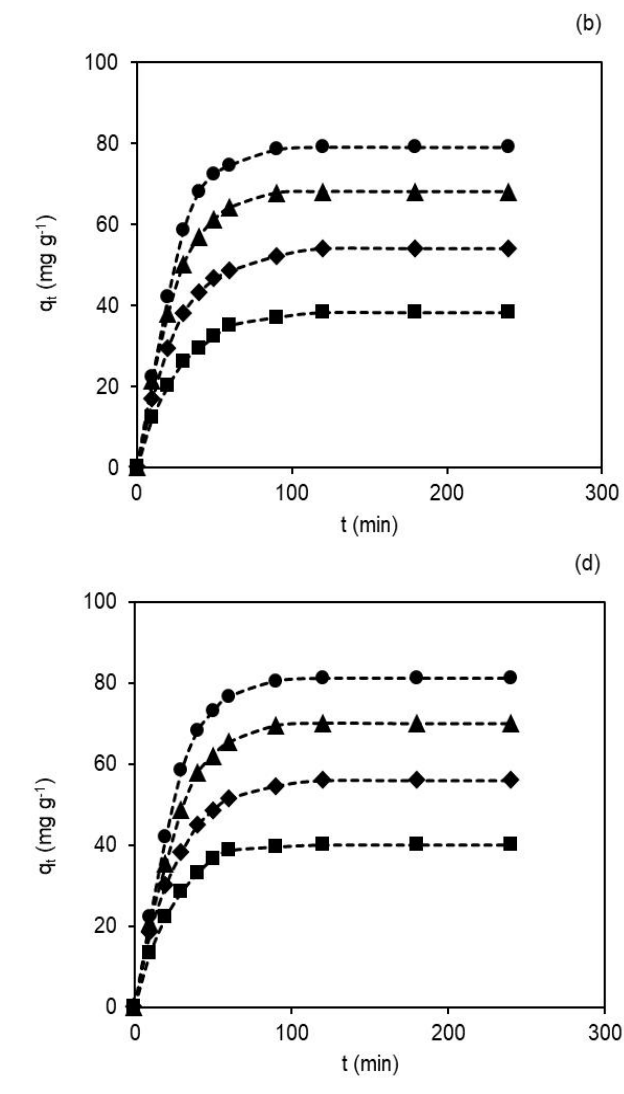
Figure 3. Contact time (0–240 min) and initial dye concentration’ effects (40 mg L − 1 ( ■ ), 60 mg L − 1 ( ♦ ), 80 mg L − 1 ( ▲ ) and 100 mg L − 1 ( ● )) on the membranes’ adsorption capacity, in pH~7 and 25 ± 0.5 °C: ( a ) M0, ( b ) M1, ( c ) M2 and ( d ) M3.